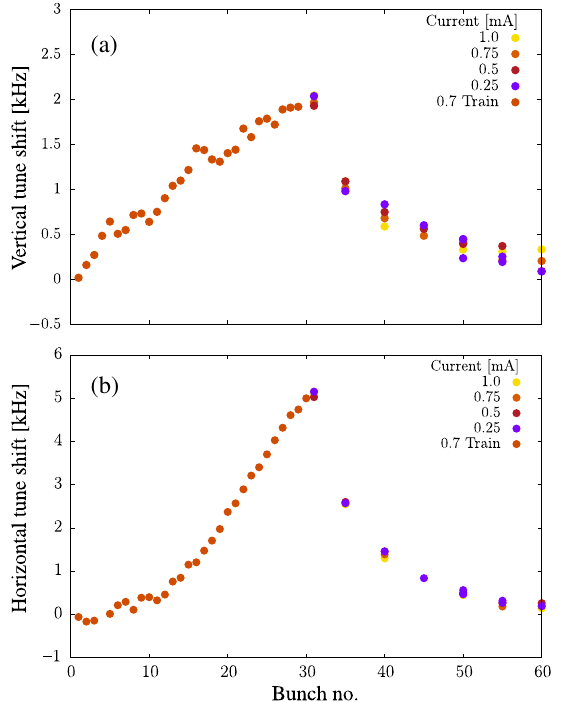
FIG. 26. Tune shifts measured in the (a) vertical and (b) hori- zontal planes using the tune tracker for a 30-bunch train of positrons at 0 . 7 mA = bunch ( 1 . 12 × 10 10 bunch population) at 2.1 GeV, followed by a witness bunch in bunch positions 31 – 60 at currents of 0.25, 0.5, 0.75, and 1.0 mA. The vertical tune shift from impedance ( ≃ − 1 . 0 kHz = mA) has been subtracted to show only the contribution from the electron cloud. No dependence of the tune of the witness bunch on the witness bunch current is seen, showing that the pinch effect does not contribute to the tune shift.